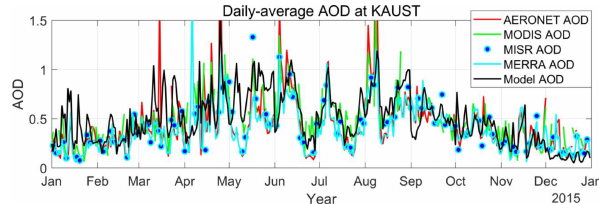
Figure 4. Time series of daily-averaged AOD at KAUST (AERONET, MODIS, MERRA-2, and model AODs at 550nm and MISR AOD at